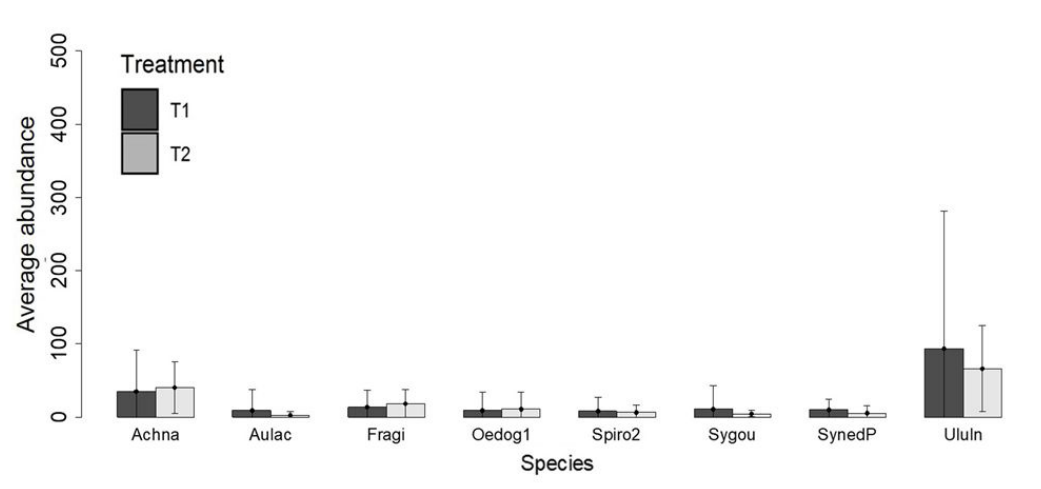
Figure 3. Abundance of periphytic algal species recorded in the treatments T1 (without zooplankton) and T2 (with zooplankton). Achna - Achnanthidium minutissimum ; Aulac - Aulacoseira sp.1; Fragi - Fragilaria sp.1; Oedog1 - Oedogonium sp.1; Spiro2 - Spirogyra sp.1; Sygou - Synedra goulardii ; SynedP - Synedra sp.1; Ululn - Ulnaria ulna.